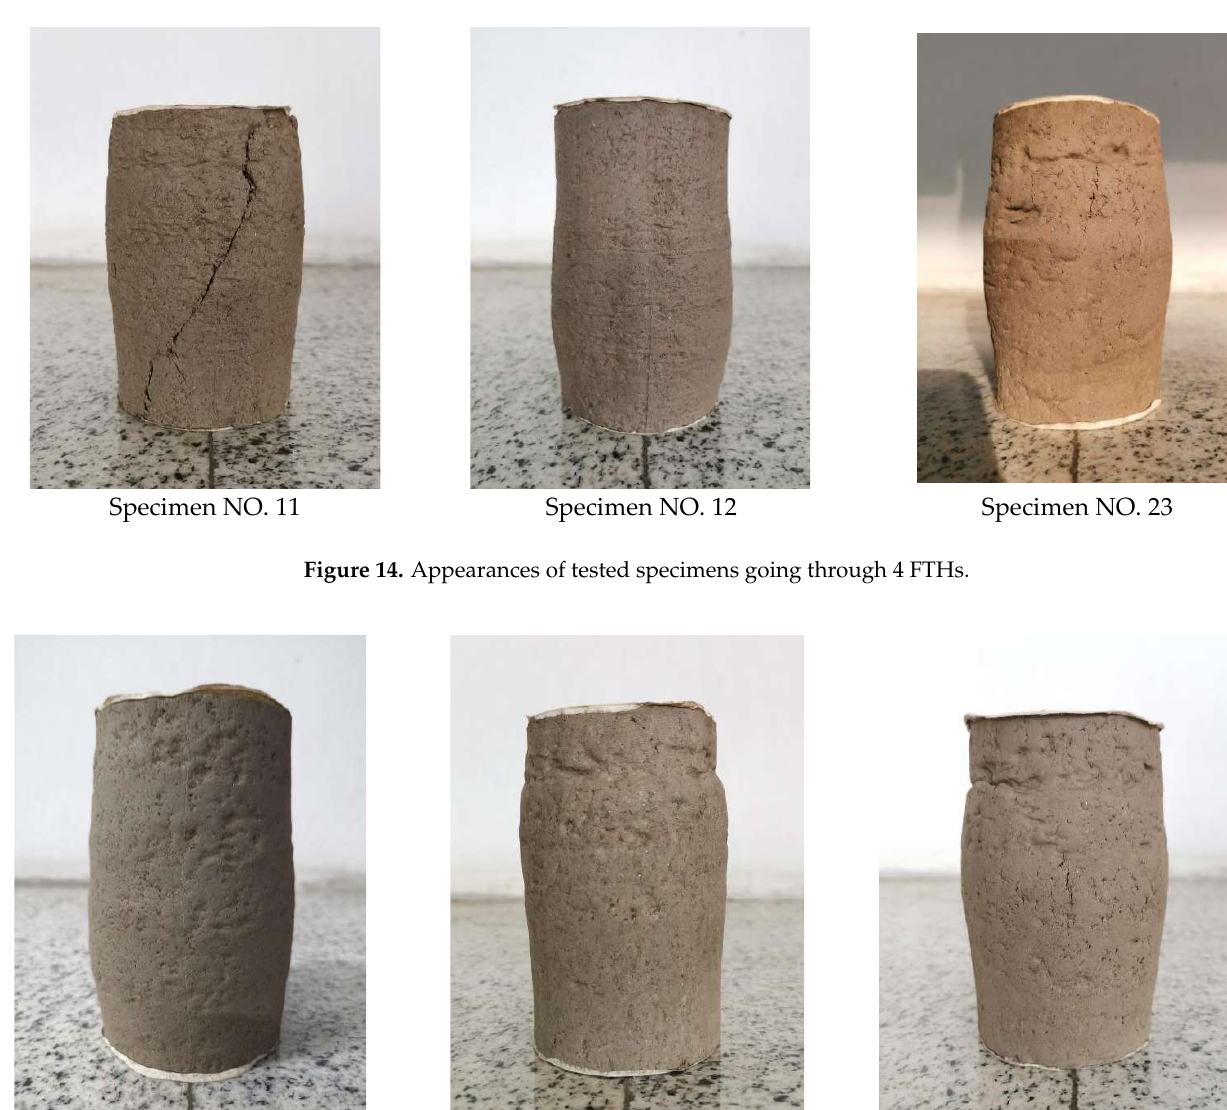
Figure 15. Appearances of tested specimens going through 7 FTHs.